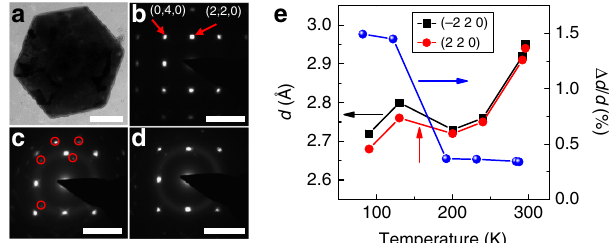
Figure 3 | Temperature-dependent selected area electron diffraction (SAED) patterns. ( a ) Low-resolution TEM image of a perovskite microplate. The scale bar is 1 m m. ( b – d ) The SAED patterns of the microplate at 296K ( b ), 90K ( c ) and 200K ( d ) along [001] zone axis. The scale bar is 5nm (cid:2) 1 . The red circles in c indicate the dispersive distributed spots. ( e ) Lattice spacings of ( (cid:2) 2 2 0) plane (black squares) and (2 2 0) plane (red squares) of a perovskite microplate. The percentage of lattice spacing difference between those two planes (defined as ( d ( (cid:2) 2 2 0) (cid:2) d (2 2 0))/ d (2 2 0)) is displayed as well (right axis). The increasing difference between these two lattice spacings with the reducing temperature indicates the transitions from a tetragonal phase to orthorhombic